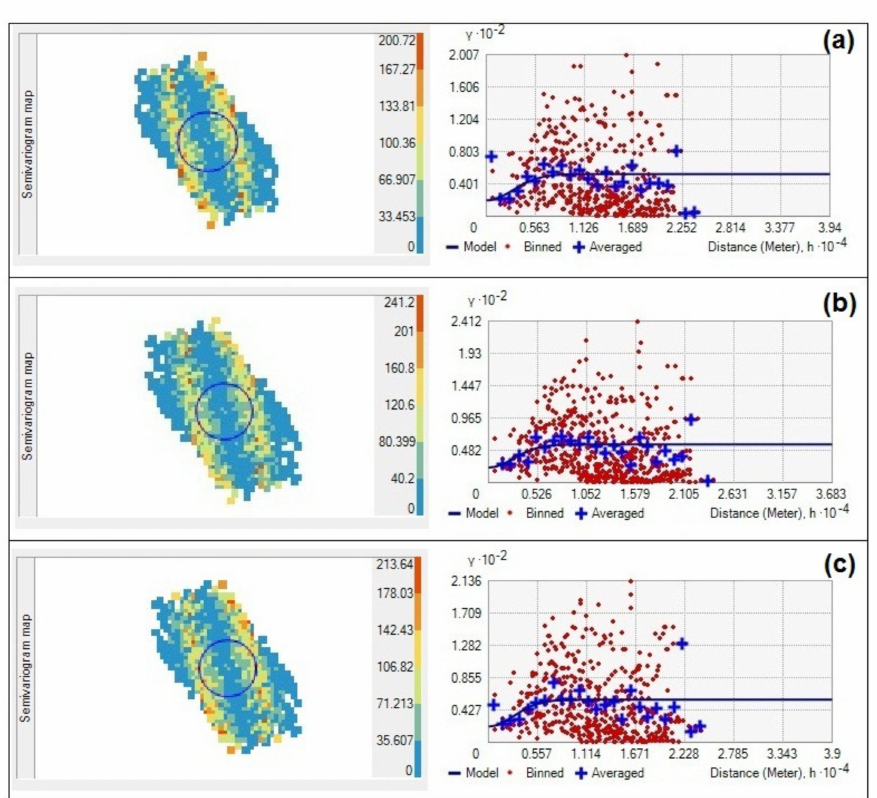
Figure 11. Semivariogram surface maps of radon data and modelled experimental variograms were calculated for data collected in the study area ( a ) related to 2017–2018 data; ( b ) related to 2018–2019 data; ( c ) related to 2019–2020